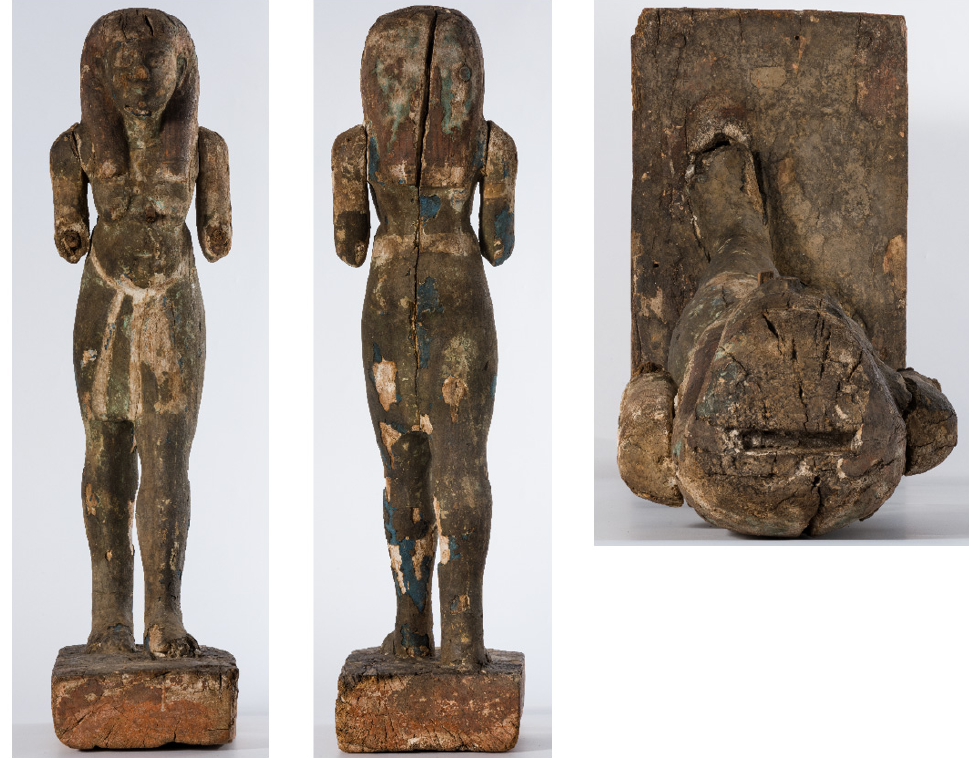
Figure 14. The artefact after the cleaning